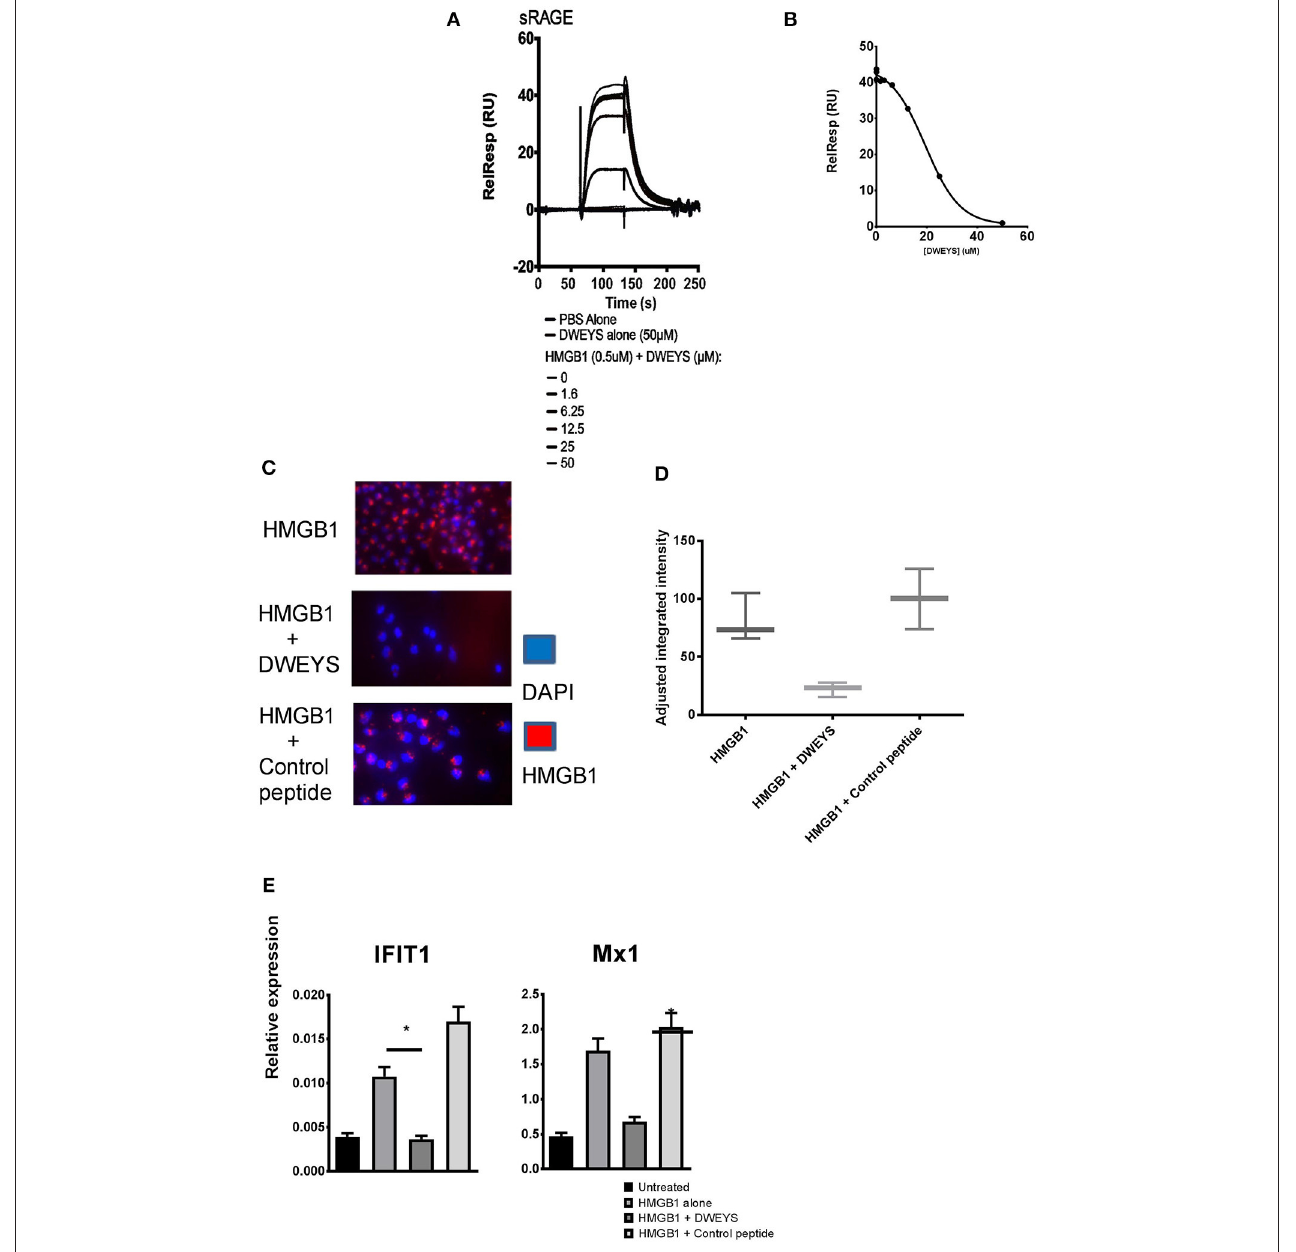
FIGURE 5 | (A) Biacore T200 analysis of DWEYS inhibition of HMGB1-RAGE binding. sRAGE was immobilized on a CM5 sensor chip, HMGB1 with or without varying concentrations of DWEYS were added as analytes. IC50 was 34.7 µ M. (B) Inhibition curve used for IC50 evaluation as noted in the methods section. (C,D) Human monocytes were incubated with labeled HMGB1 (red) alone ( C , top panel) or HMGB1 and DWEYS ( C , middle panel) or HMGB1 and control peptide ( C , bottom panel) for 20 min. Cells were counterstained with DAPI and imaged using a confocal laser scanning microscope. (D) Indicates adjusted fluorescence intensity for three experiments. (E) Primary human monocytes were incubated with HMGB1 and with or without DWEYS or control peptide for 4h. lSG expression was evaluated using qPCR. Results indicate mean ± SD of three independent experiments. * p <